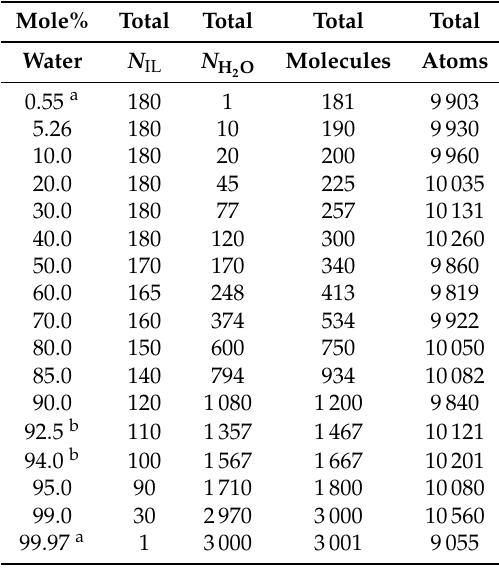
Table 1. Compositions of TBPH/tetrabutylphosphonium chloride (TBPCl)-water systems simulated in this